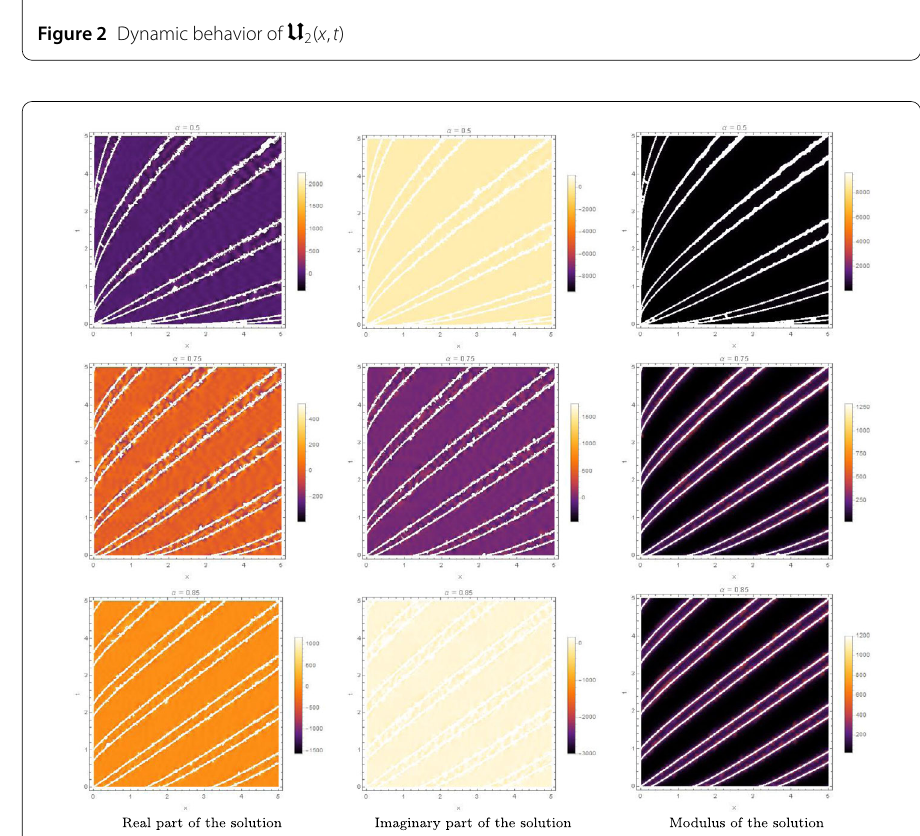
Figure 3 Dynamic behavior of U 6 ( x , t